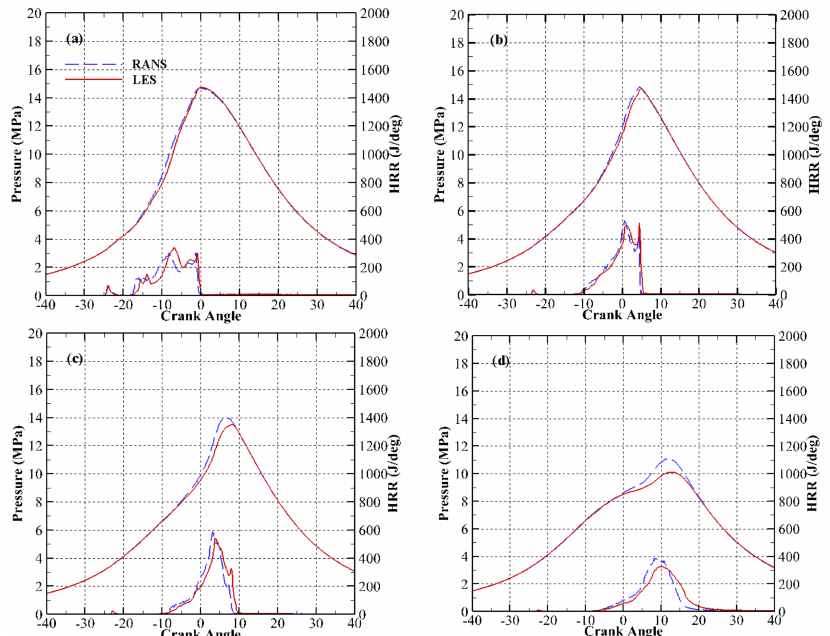
Figure 4. Comparison of Large eddy simulation (LES) and Reynolds-averaged Navier–Stokes (RANS) model for cylinder pressure and heat release rate variations: ( a ) 50%; ( b ) 75%; ( c ) 80% and ( d ) 85% natural gas mass fractions.